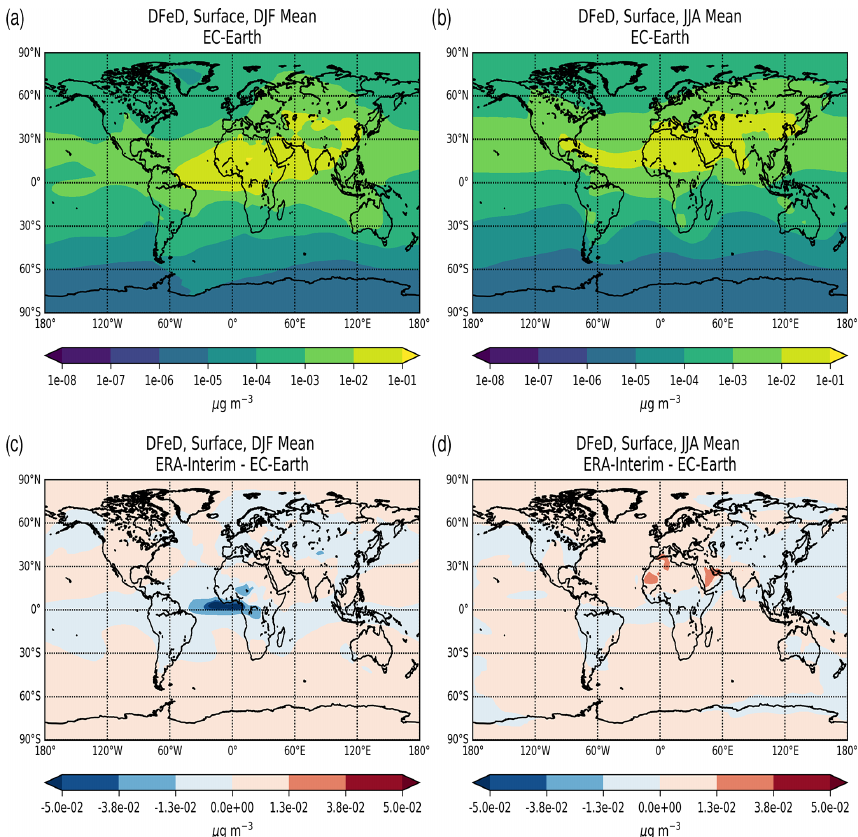
Figure 9. Dissolved iron surface concentrations (µgm − 3 ) from mineral dust (DFeD) for the boreal winter (DJF; a ) and summer (JJA; b ) seasons for the EC-Earth simulation, averaged for the period 2000–2014, and the respective absolute differences to the ERA-Interim simulation (c, d)